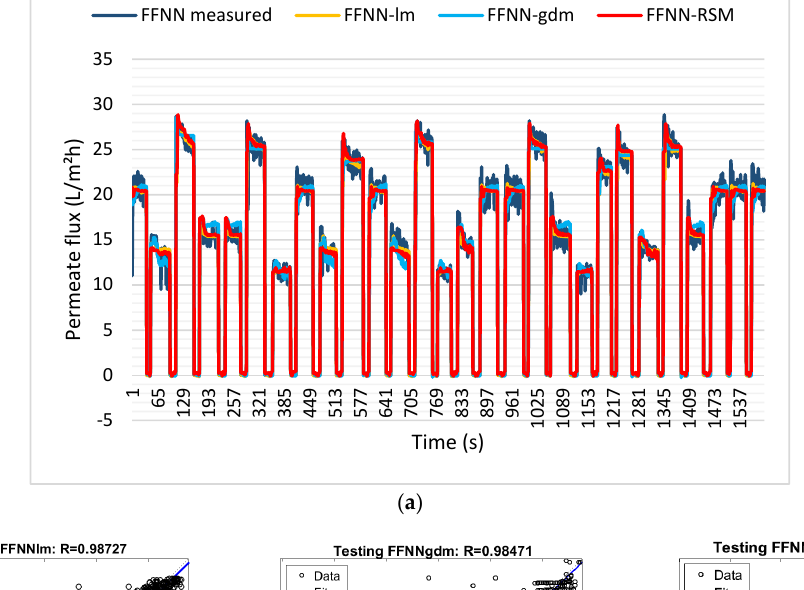
Figure 11. ( a ) Permeate flux for FFNN − measured, FFNN − lm, FFNN − gdm, and FFNN − RSM models. Comparison of the measured and predicted permeate flux of POME between ( b ) FFNN − lm, ( c ) FFNN − gdm, and ( d ) FFNN − RSM for the training dataset.